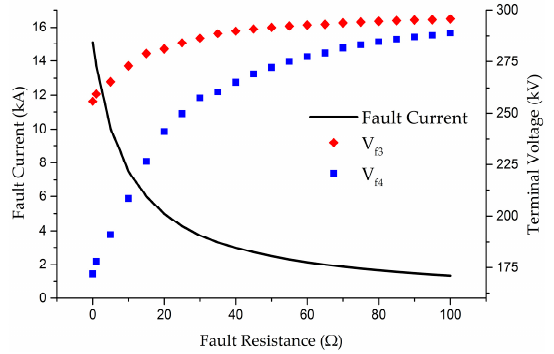
Figure 12. Effects of fault resistance on fault current and the surrounding terminal voltage.